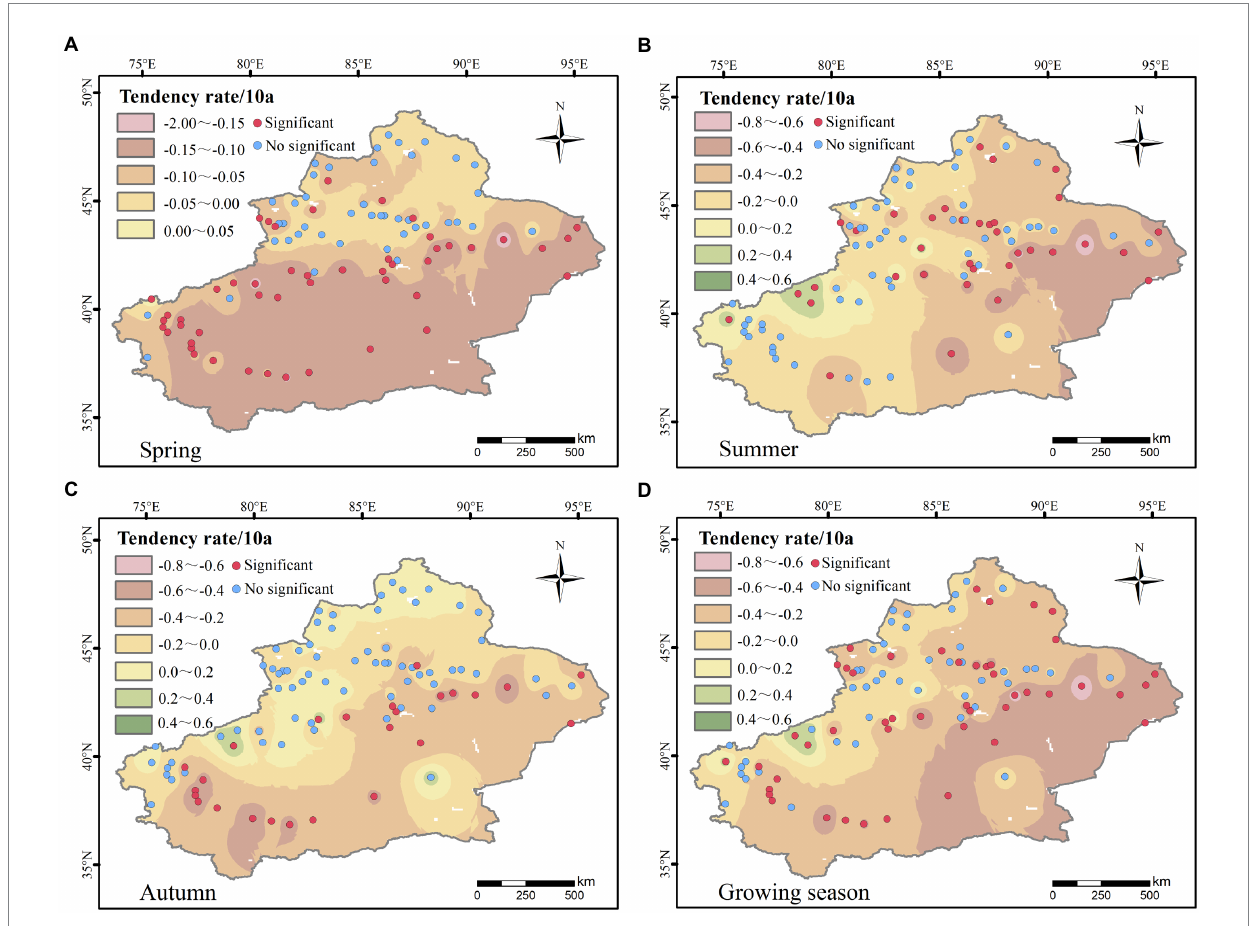
FIGURE 7 Spatial variation in SPEI series propensity rates in (A) spring, (B) summer, (C) autumn, and (D) the growing season in Xinjiang from 1982 to